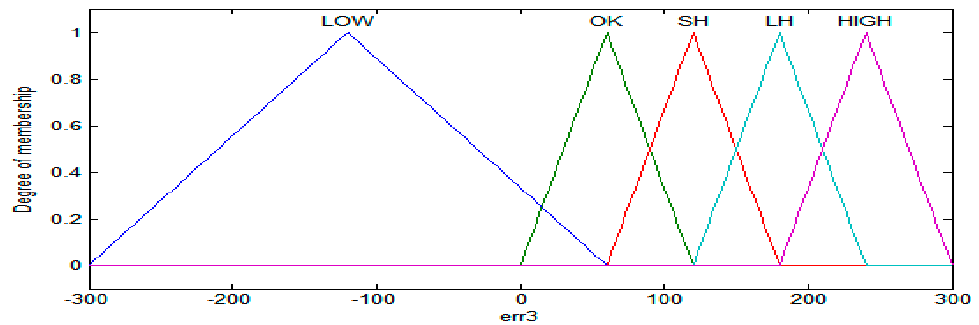
Figure 12. Air quality fuzzy controller inputs.